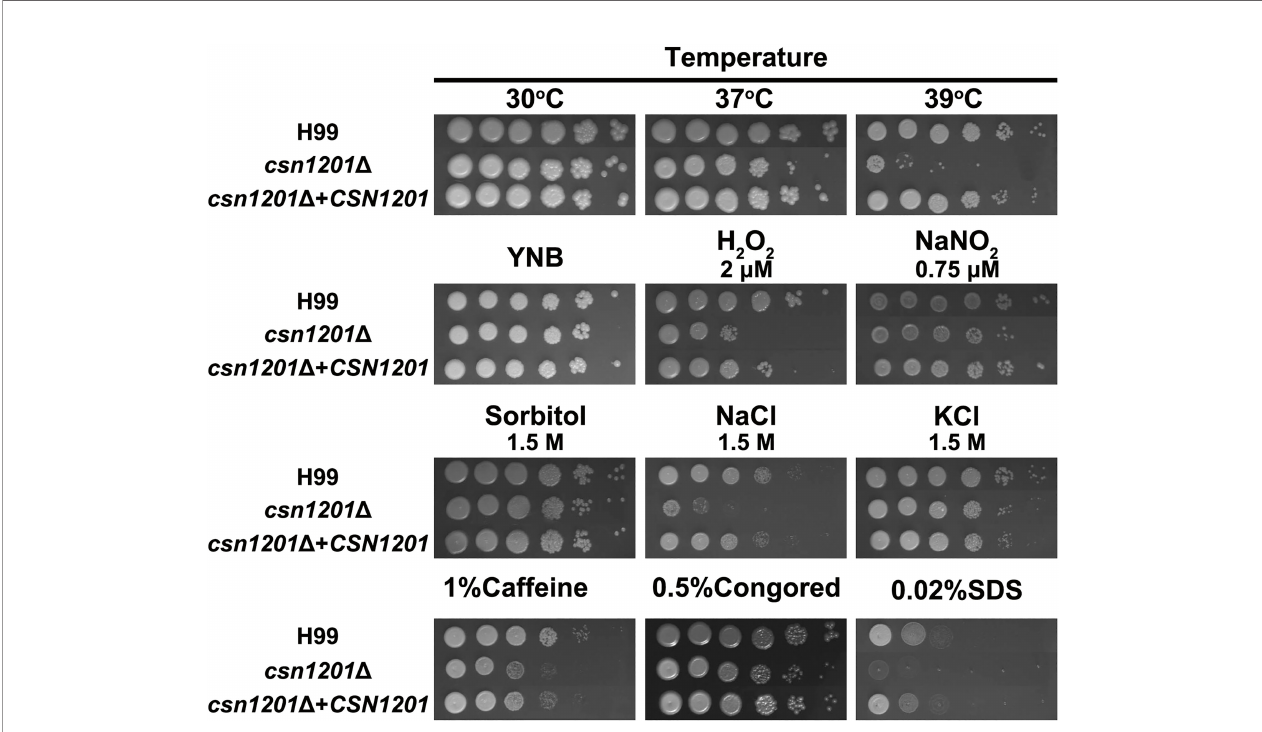
FIGURE 1 | Csn1201 is involved in various stress responses of C. neoformans . Strains were grown to saturation at 30°C in YPD medium, washed, serially diluted 10-fold (1 – 10 6 dilutions), and spotted (4 µL) onto YNB or YPD agar medium containing different stress-inducing agents. Spotted cells were incubated at 30°C for 3 days and then